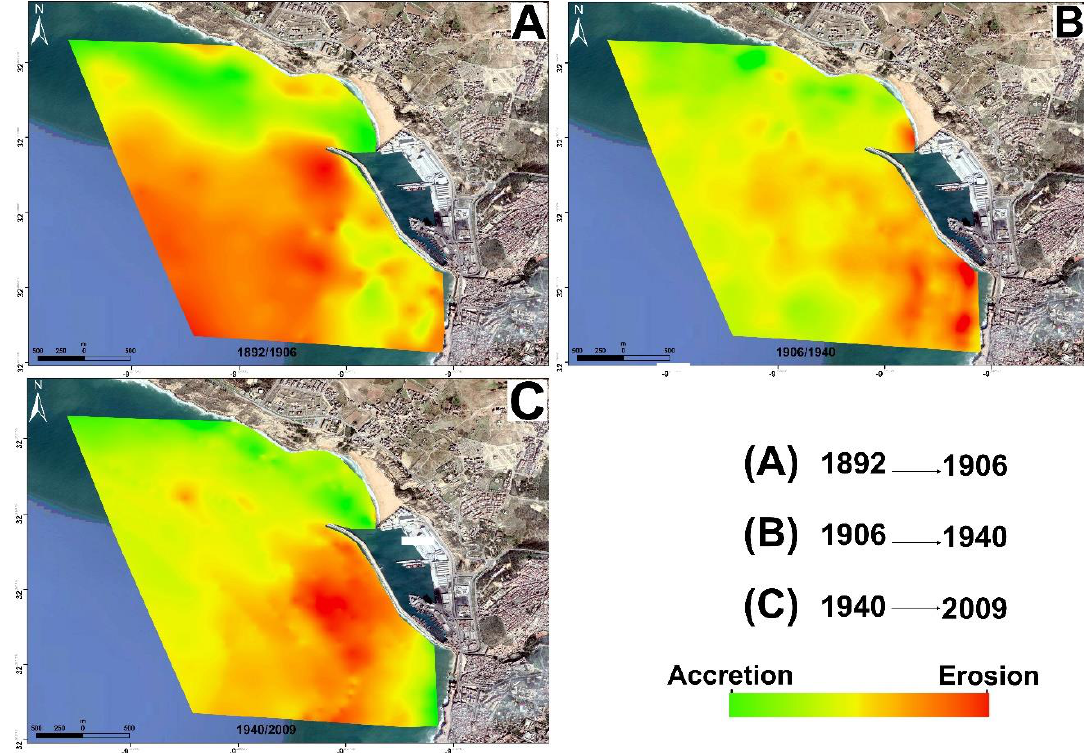
Figure 6. Erosion-accumulation patterns in the bay of Safi for the period from 1892-2009